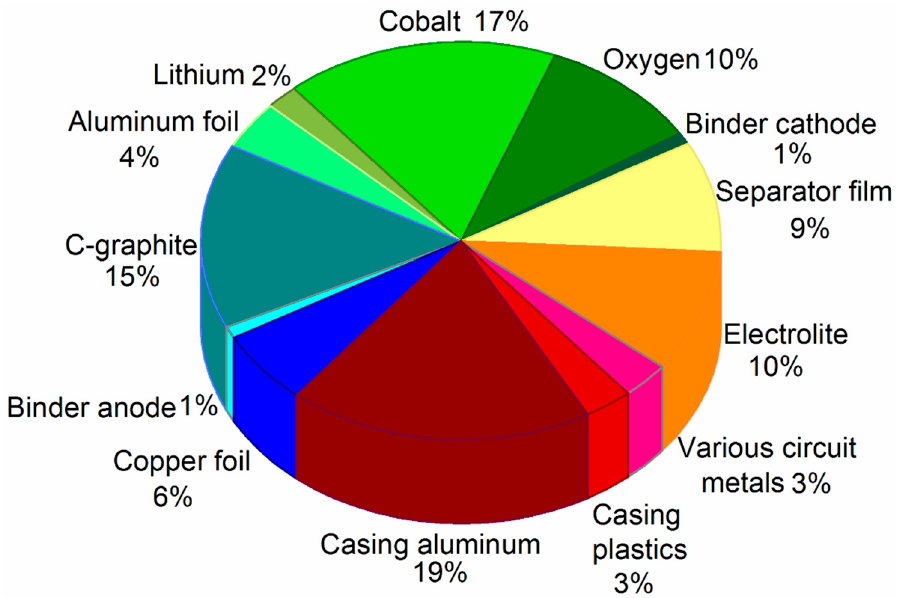
Figure 2. Composition % weight of LIBs.